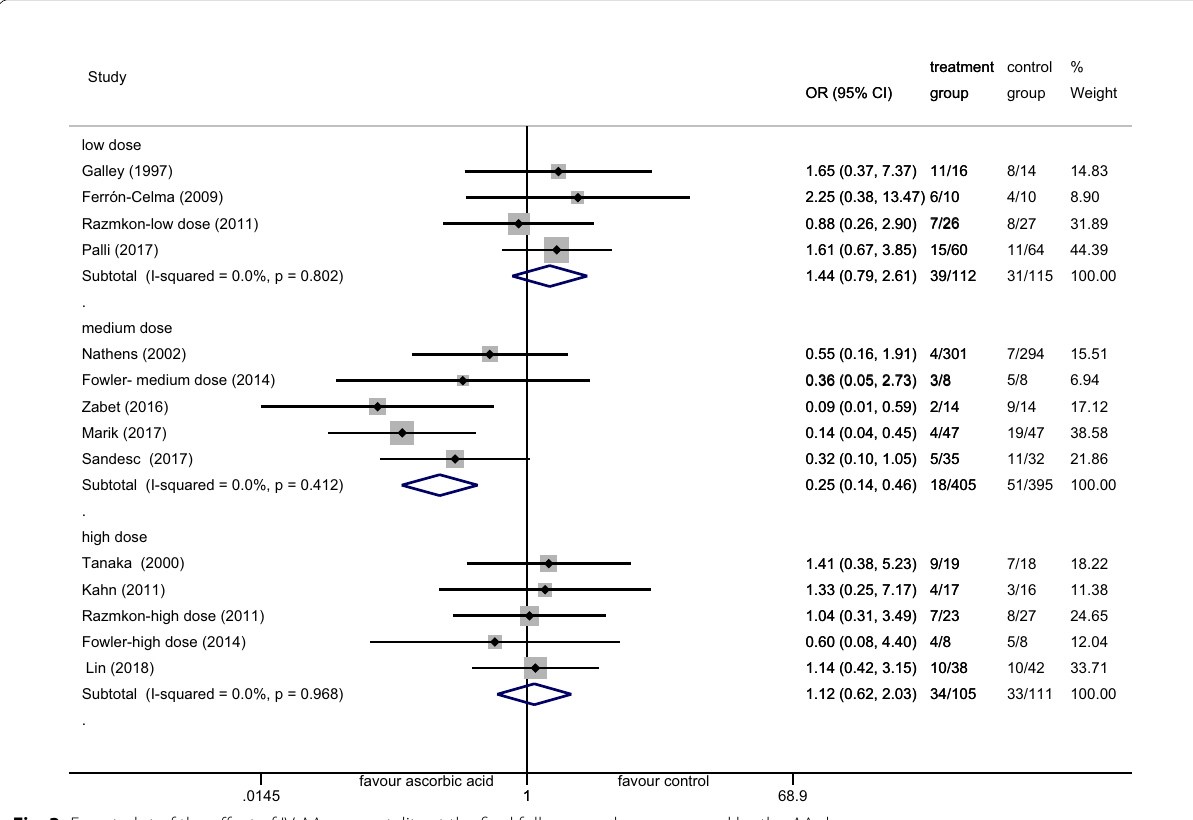
Fig. 5). For heterogeneity analysis, a random (M-H het- erogeneity) model was applied. For sensitivity analysis, removal of the Zabet et al. [16] study led to an increased urine output in response to AA (SMD 0.72; 95% CI = (0.23–1.21); p 0.004; I 2 47.1, Additional file 3: Fig. S3). = =